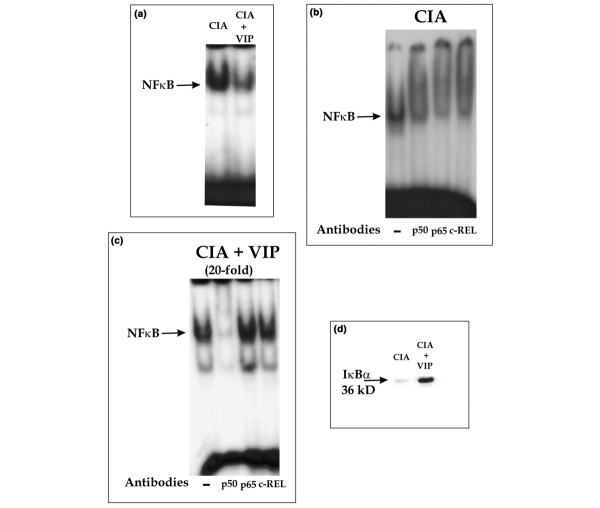
Effect of vasoactive intestinal peptide (VIP) on NFκB binding and IκB degradation in synovial cells from mice with collagen-induced arthritis (CIA). (a) EMSA results from nuclear extracts of synovial cells from CIA or VIP-treated CIA mice, using a radiolabeled oligonucleotide containing the NFκB consensus binding site. (b) Supershift assay on nuclear extracts of CIA mice using anti-p50, anti-p65 or anti-cRel. (c) Supershift assay (20-fold amplified) on nuclear extracts of VIP-treated CIA mice using anti-p50, anti-p65 or anti-cRel. (d) Western blot analysis showing immunoreactive IκBα (36 kDa) in cytoplasmic fractions of synovial cells from CIA and VIP-treated CIA mice. A representative experiment of three is shown.